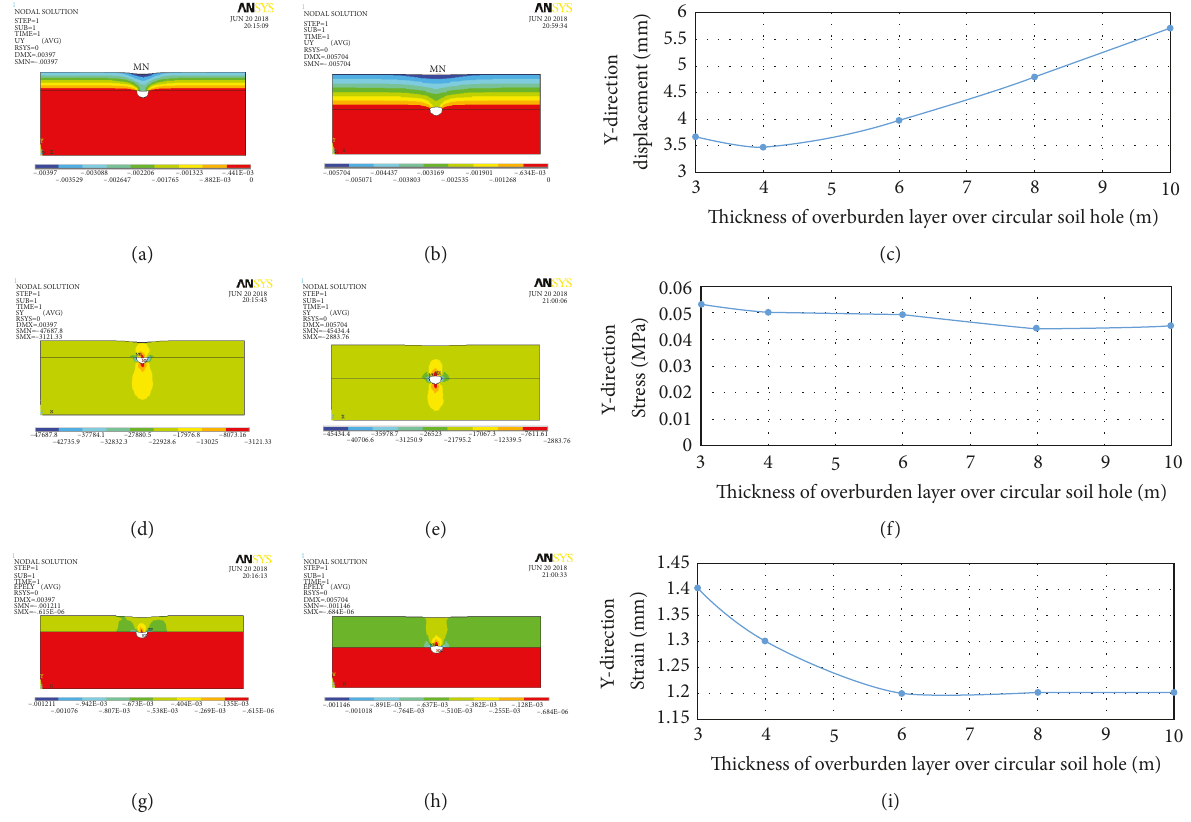
Figure 6: q � 18.43kPa scenario. Results of displacement cloud map: (a) H � 6m and (b) H � 10m; (c) displacement curve; stress cloud map: (d) H � 6m and (e) H � 10m; (f) stress curve; strain cloud map: (g) H � 6m and (h) H � 10m; (i) strain